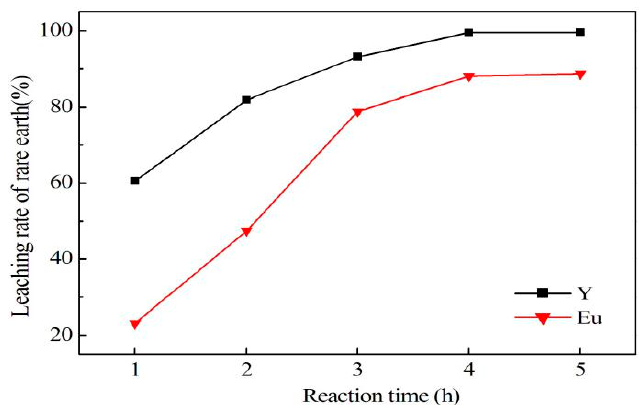
Figure 4. Effect of leaching time on the REE leaching test (4 mol/L HCl concentration, 0.2 mL/g hydrogen peroxide, 60 ° C leaching temperature).